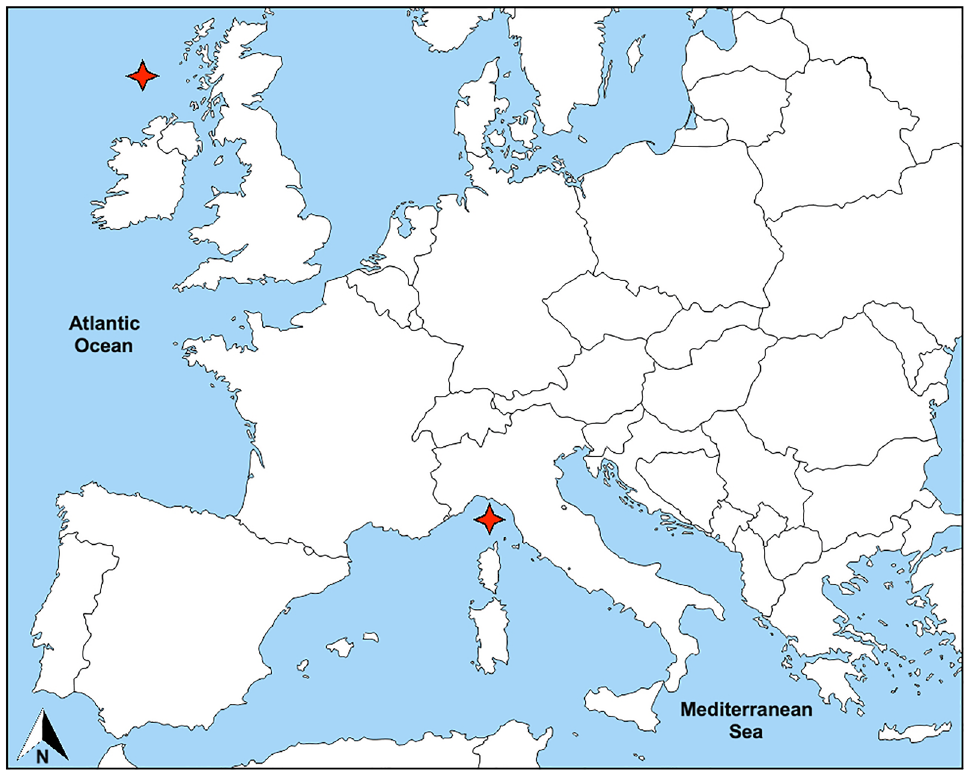
Figure 1. Sampling area of Chimaera monstrosa in the North-East Atlantic and in the Ligurian Sea (Western Mediterranean). Image modified from the original with permission (https://d- maps. com/ carte. php? num_ car= 2232& lang=